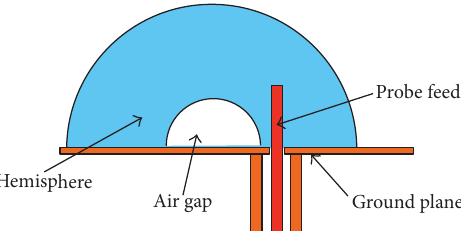
Figure 6: Probe-fed hemispherical DRA with an air gap for bandwidth enhancement as suggested in